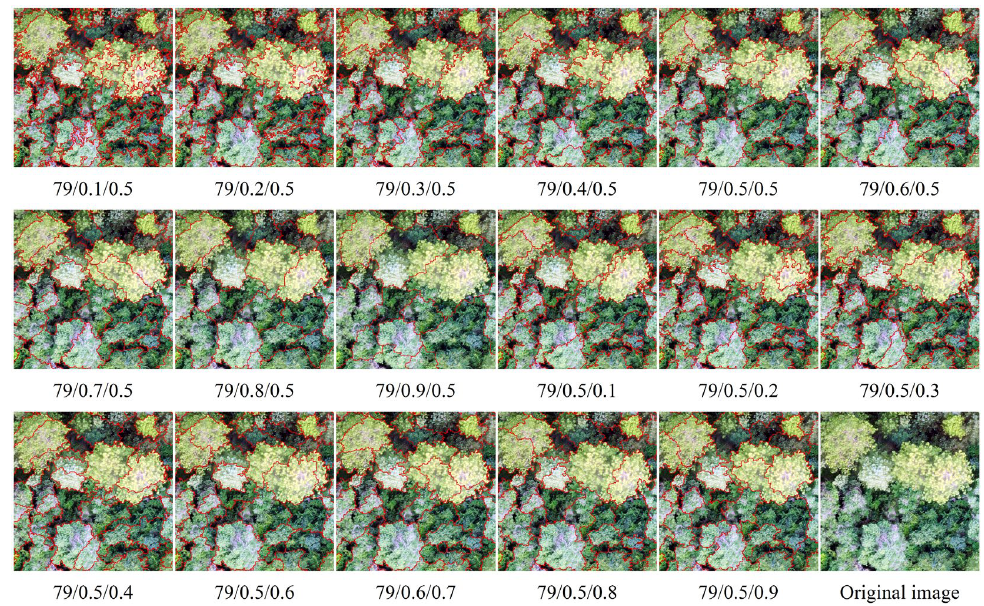
Figure 4. An alternative optimal scale segmentation effect of Shenxiantang tiankeng. The order of parameters is segmentation scale/shape/compactness. Red outlines represented the canopy con- tours formed by multi-scale segmentation. Visual interpretation of the overlap between the seg- mented outlines in red and the canopy shape of the original image. A high overlap indicated a good segmentation effect. If multiple canopies are within a red outline, it means under-segmentation; if a canopy is segmented by multiple red outlines, it means over-segmentation.